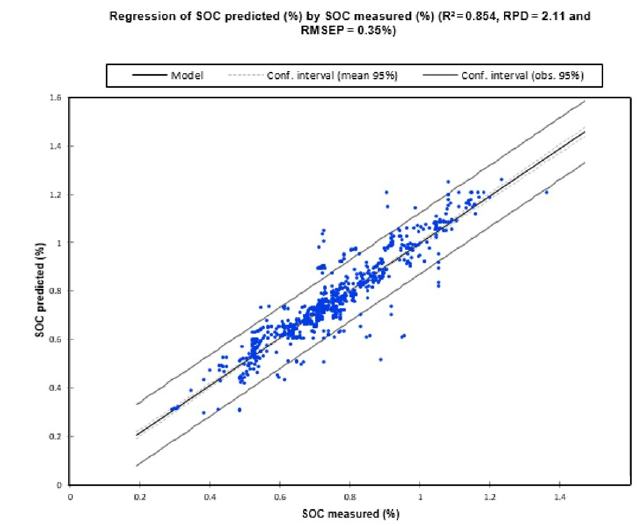
Figure 3. SOC values from chemical analysis plotted against SOC prediction.